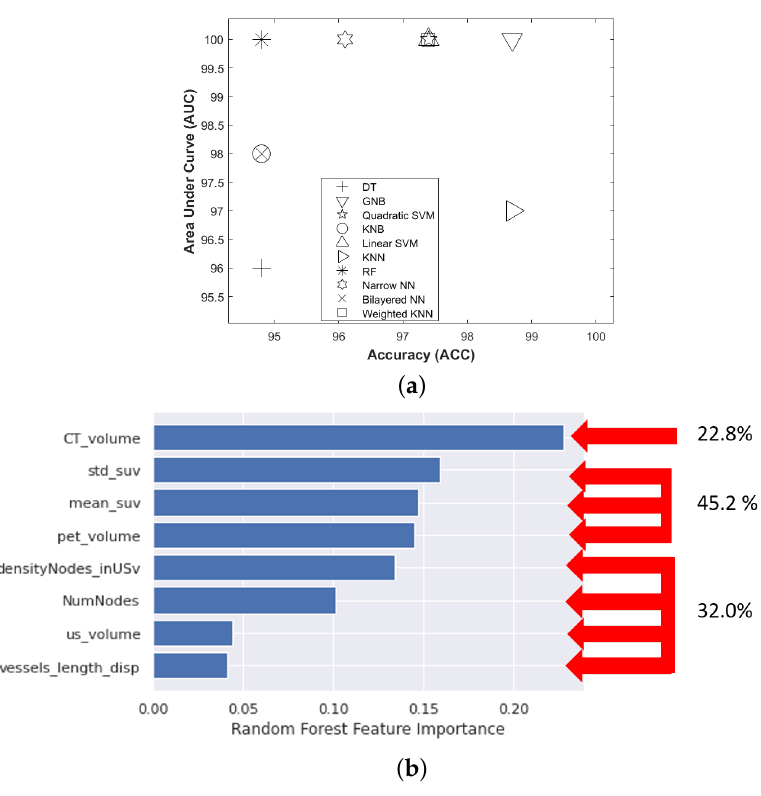
Figure 5. Performance of the supervised machine learning models ( a ) Scatter diagram of machine learning classifiers prediction performance. The horizontal axis represents accuracy (ACC), the vertical axis represents the area under the curve (AUC); DT, decision tree; GNB, Gaussian naive Bayes (Gaussian); Quadratic SVM, support vector machine (Quadratic); KNB, kernel naive Bayes; Linear SVM, linear support vector machine; KNN, k-nearest neighbors; RF, random forest; NNN, narrow neural network; Bilayered NN, bilayered neural network; Weighted KNN, weighted k-nearest neighbors. ( b ) Contribution of morphological, metabolic, and vascular features in the discrimination of the 4 clusters of tumor evolution stages identified with